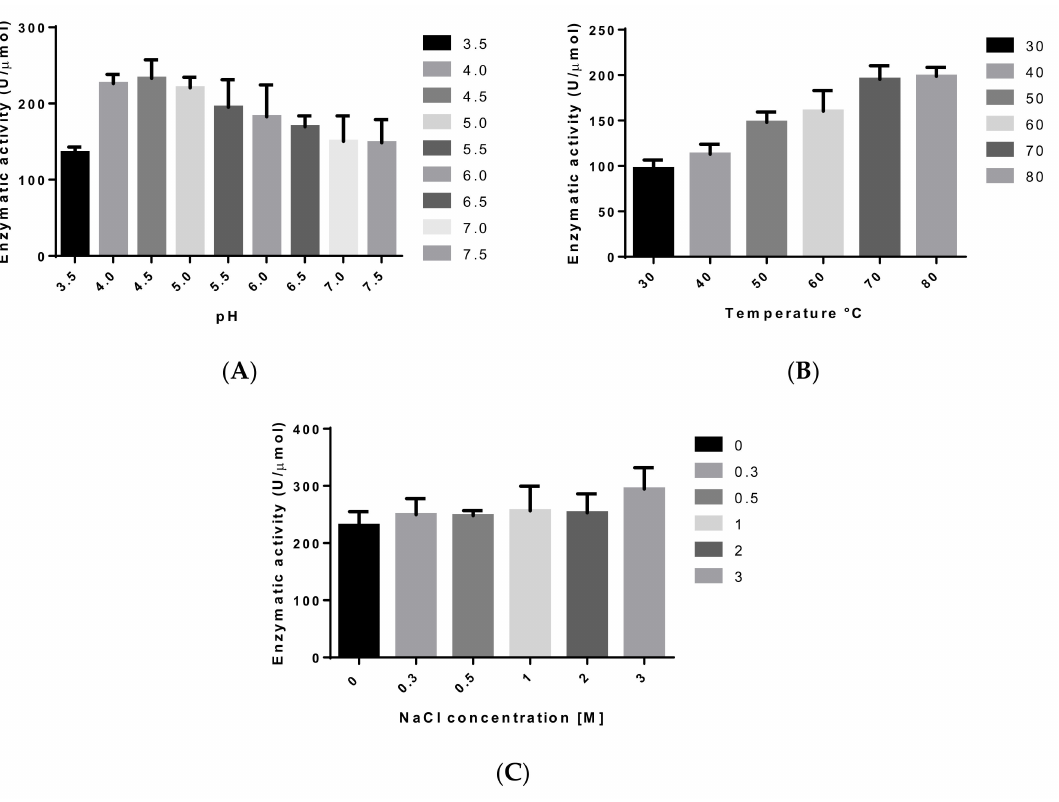
Figure 7. Functional characterization of DtCel5A. ( A – C ) panels show the effects of pH, temperature, and NaCl concentration on DtCel5A enzymatic activity,